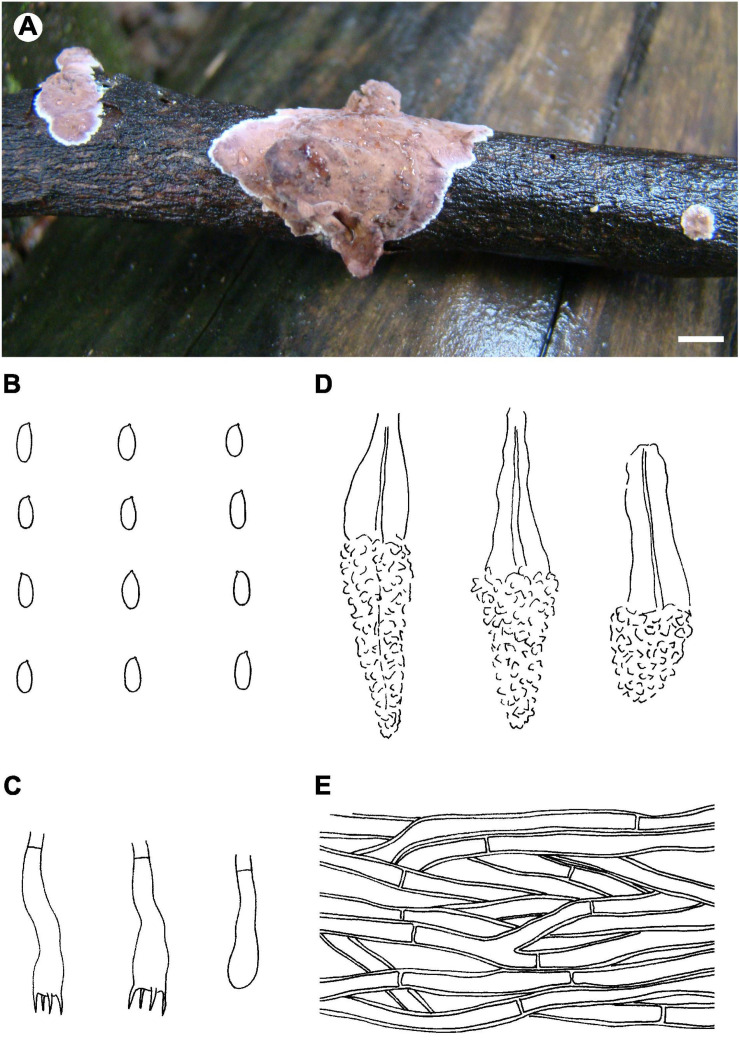
Phlebiopsis sinensis (from He 4673; scale bars: A = 1 cm, B–E = 10 μm). (A) Basidiomata; (B) basidiospores; (C) basidia and basidiole; (D) lamprocystidia; (E) hyphae from subiculum.